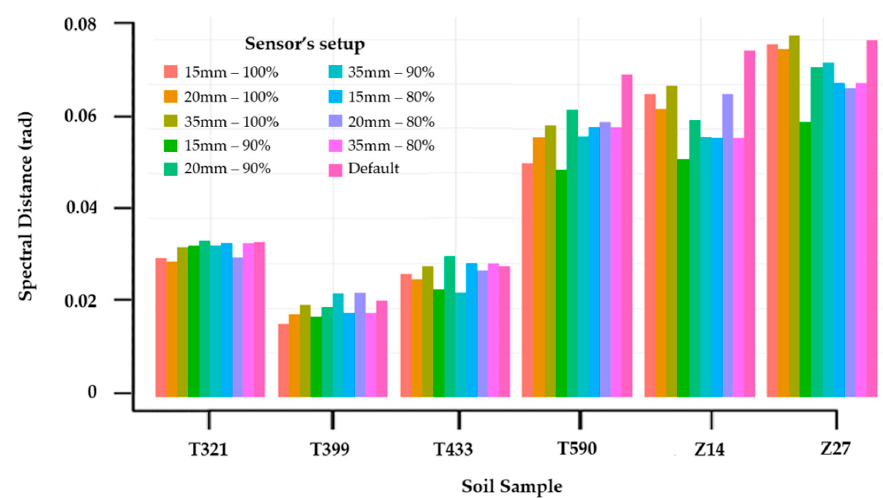
Figure 6. Angular distance calculated from Spectral Angle Mapper for each sample of the subset dataset for ten measuring scenarios. The used reference values are the spectral signatures obtained from PSR+ 3500, restricted to the 1750–2150 nm range. Table 2. Classification of evaluated scenarios according to their performance, evaluated with Spec- tral Angle Mapper (H: height and LI: light intensity).